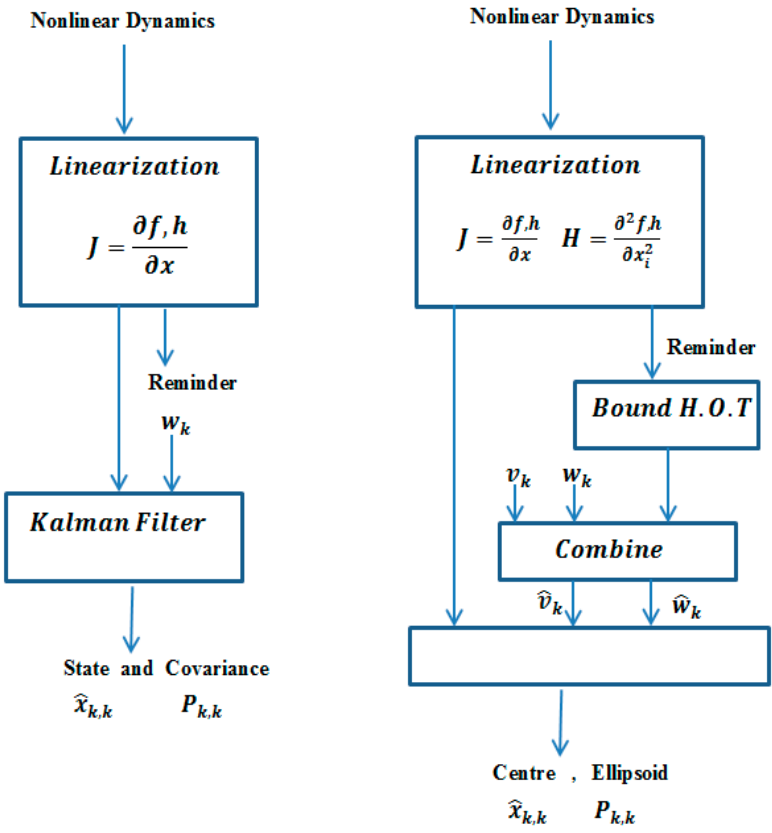
Figure 2. Simplified graphical representation of the extended Kalman filter (EKF) (left) and the nonlinear set membership filter (right) at each time step